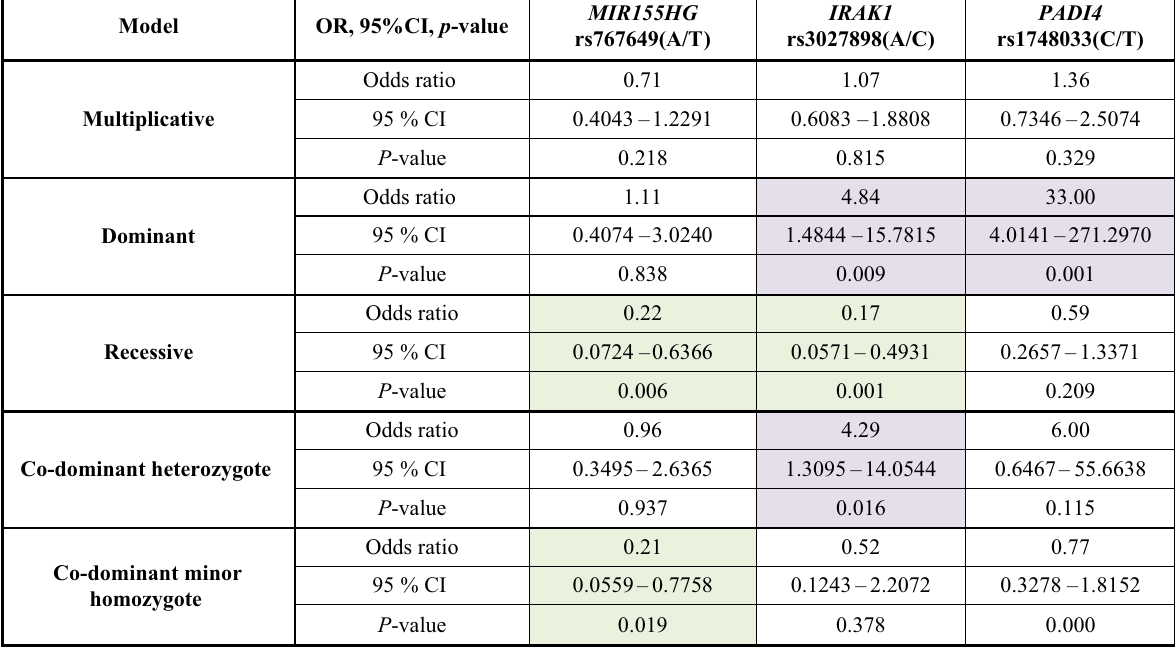
Table 3 SNP analysis of the excluded SNPs